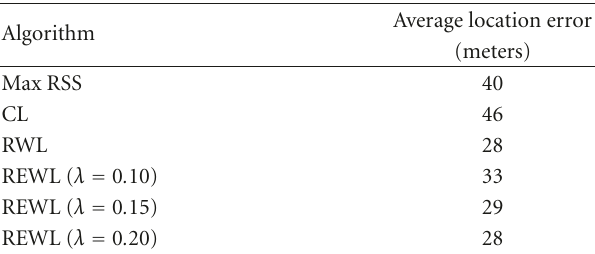
Figure 12: Algorithm location error for experimental data. Table 2: Average location error for all transmitter